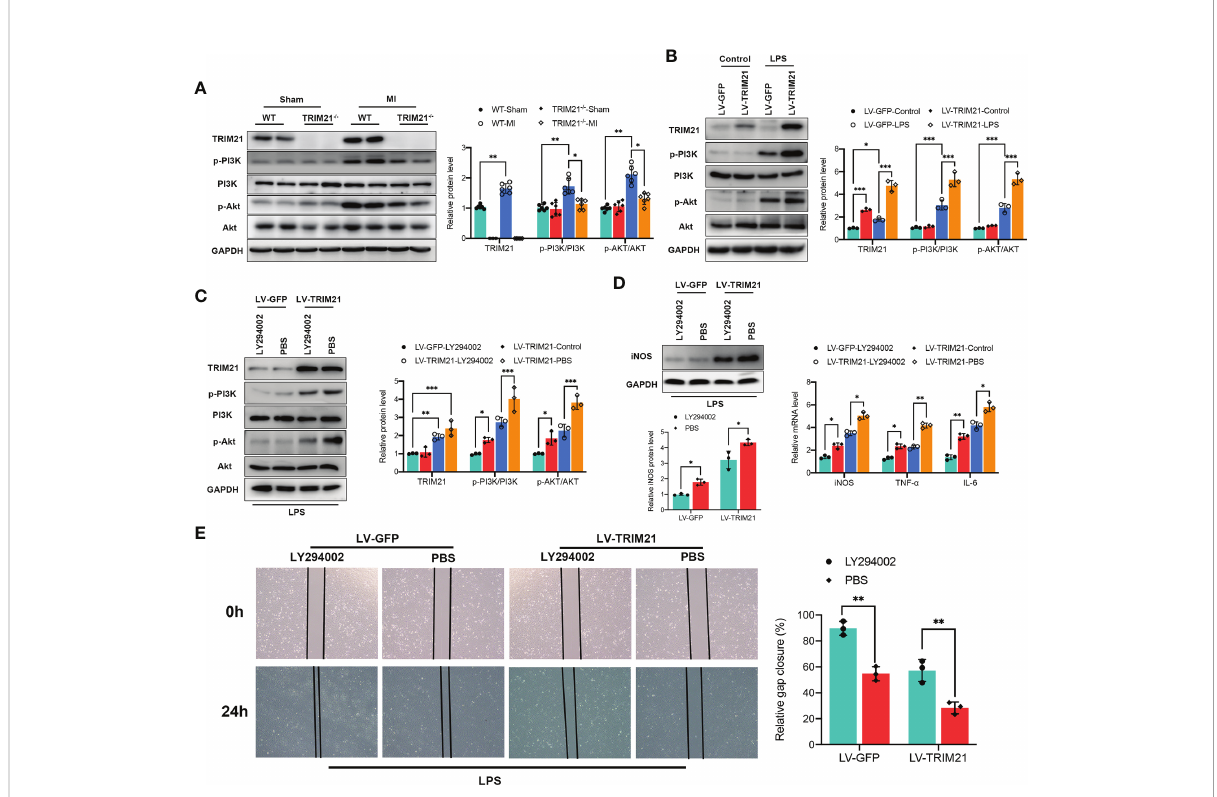
FIGURE 7 TRIM21 regulates macrophage polarization by the PI3K/Akt pathway. (A) The protein levels of TRIM21, p-PI3K, PI3K, p-AKT and AKT on day 3 post-MI in the infarct zone isolated from WT and TRIM21 -/- mice. (B) The protein levels of TRIM21, p-PI3K, PI3K, p-AKT and AKT in LPS- stimulated RAW264.7 cells transfected with LV-GFP or LV-TRIM21, (C) and in LV-GFP and LV-TRIM21 group treated with LY294002 or PBS after LPS exposure. (D) The protein levels of iNOS (left) and mRNA levels of iNOS, TNF- a , and IL-6 (right) in LV-GFP and LV-TRIM21 group treated with LY294002 or PBS. (E) Representative images and quanti fi ed results of gap closure of cardiac fi broblast cultured in conditioned medium from LV-GFP and LV-TRIM21 macrophages treated with LY294002 or PBS macrophages after LPS exposure. For (A-E) , data are representative of 3 independent experiments. n = 3 sets of cells/group. *P<0.05, **P<0.01, and